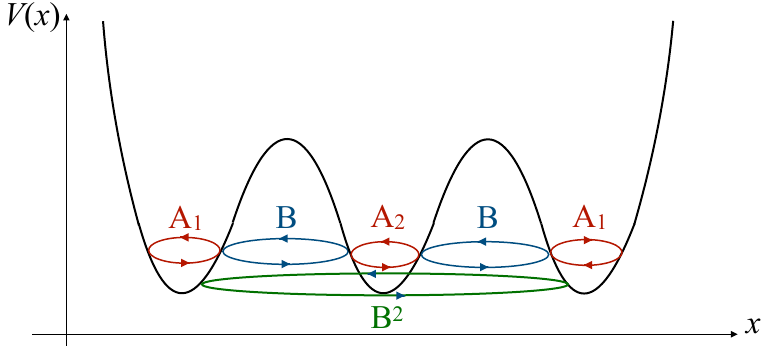
Figure 12 . Relationship between periodic orbits and the Maslov index for the symmetric triple-well potential. The index ( − 1) n in the n -the sector in eq. (5.16) is determined by counting a cycle-unit which can be decomposed into the following parts; two B/ ( D A former part including one B -cycle corresponds to an orbit running around two (locally) double-well potential, [ A 1 - B - A 2 ] and [ A 2 - B - A − 1 an orbit which is globally running from the left to the right [ A 1 - B - A 2 - B - A − 1